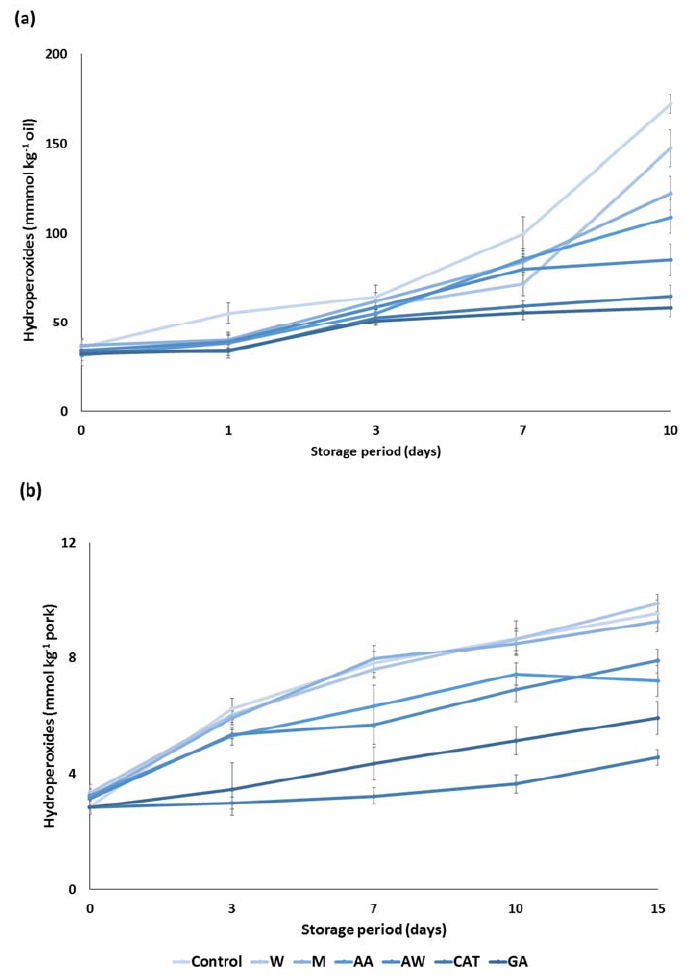
Figure 3. Antioxidant activity of the carob extracts, gallic acid, and catechin in ( a ) sunflower oil and ( b ) pork model system. The symbols W, M, AW, AA represent the water, methanol, acetone–water and acidic acetone extracts; GA and CAT denote gallic acid and catechin, respectively.